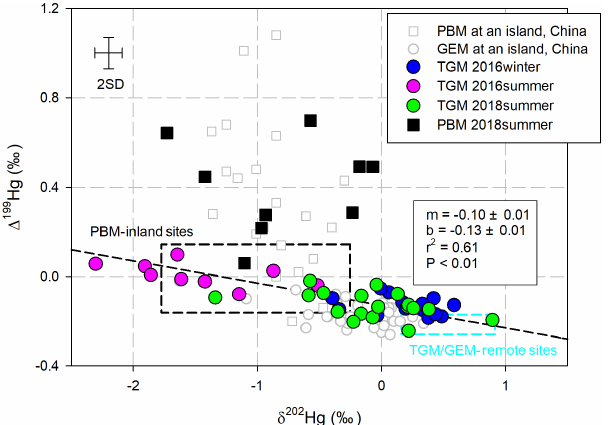
Figure 1. Scatter plot of (cid:49) 202 Hg and (cid:49) 199 Hg in TGM and PBM samples in this study illustrated with reported isotopic compositions in GEM (Fu et al., 2018) and PBM (Fu et al., 2019a) collected at the Huaniao island site in the East China Sea. The reported data ranges (mean ± SD) of isotopic compositions in TGM / GEM are from remote sites globally (Demers et al., 2015; Yu et al., 2016; Demers et al., 2013; Fu et al., 2016), and PBM data are from inland sites (Yu et al., 2016; Das et al., 2016; Huang et al., 2015, 2016; Xu et al., 2017). Error bars refer to max 2 σ for samples in this